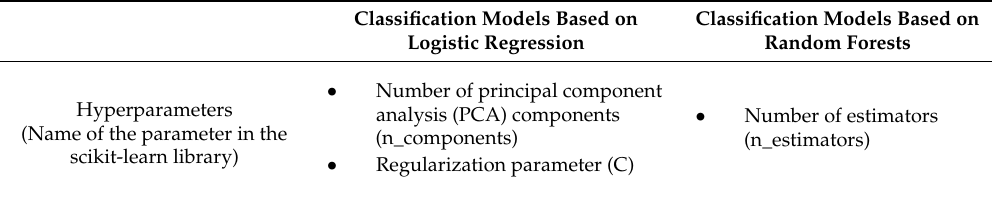
Table 1. Hyperparameters of the